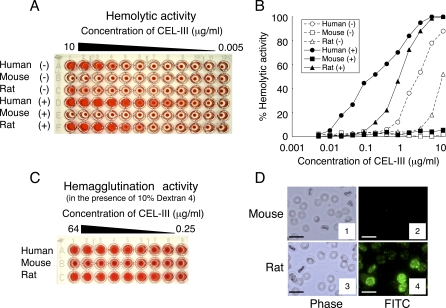
Hemolytic and Hemagglutination Activities of CEL-III toward Human, Mouse, and Rat Erythrocytes(A) Serial 2-fold dilutions of CEL-III were mixed with human, mouse, or rat erythrocytes in V-shaped microtiter plate wells. Samples were incubated in the absence (−) or presence (+) of 5% FBS. Hemolysis was examined visually after incubation for 1 h at room temperature.(B) Hemolytic activity toward human, mouse, and rat erythrocytes was expressed as the absorbance at 550 nm resulting from release of hemoglobin.(C) Serial 2-fold dilutions of CEL-III were mixed with human, mouse, or rat erythrocytes in V-shaped microtiter plate wells. Samples were incubated in the presence of 10% Dextran 4. Agglutination was examined visually after incubation for 1 h at room temperature.(D) CEL-III was added to mouse (panels 1 and 2) or rat erythrocytes (panels 3 and 4), and bound CEL-III was detected with FITC-labeled anti-mouse IgG following mouse anti-CEL-III antibody by fluorescence microscopy. Panels 1 and 3, phase contrast; panels 2 and 4, FITC. Scale bars are 10 μm.